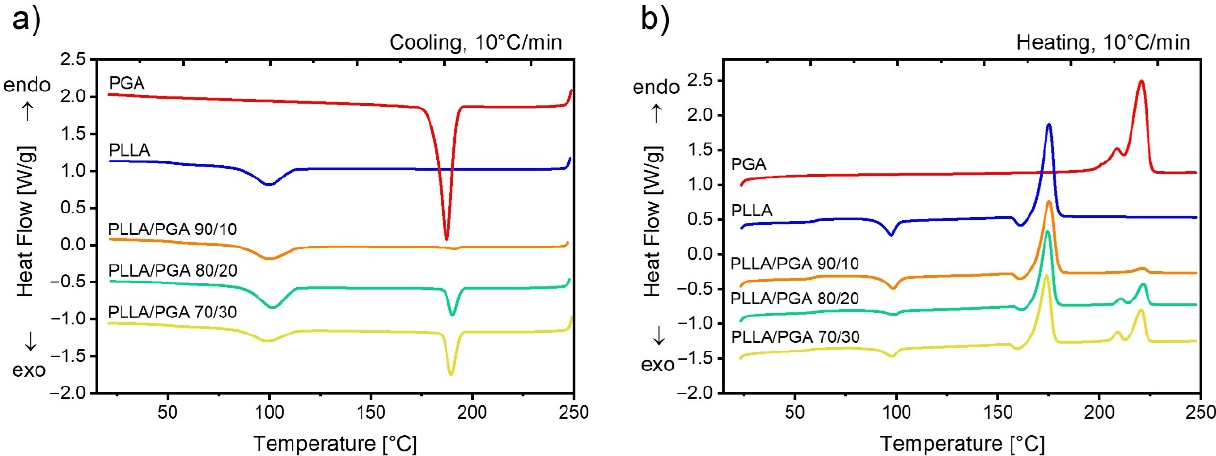
Figure 4. DSC cooling ( a ) and heating ( b ) scans for the neat polymers and PLLA/PGA blends of indicated compositions.